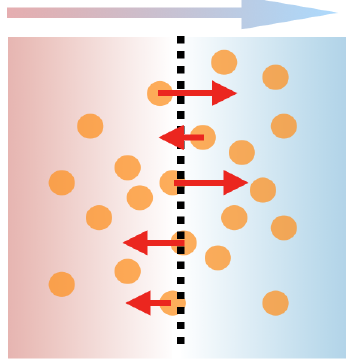
Figure 1: Schematic illustration depicting counting statistics in a steady state regime. One “counts" the number of particles (or their energy or charge) passing a given coordinate during a large time interval and then gathers the statistics of these large numbers, scaled with